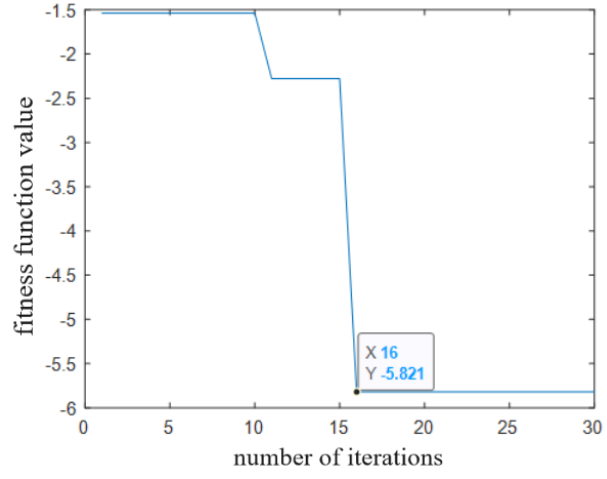
Figure 14. Fitness function curve of the inner ring experimental signal.